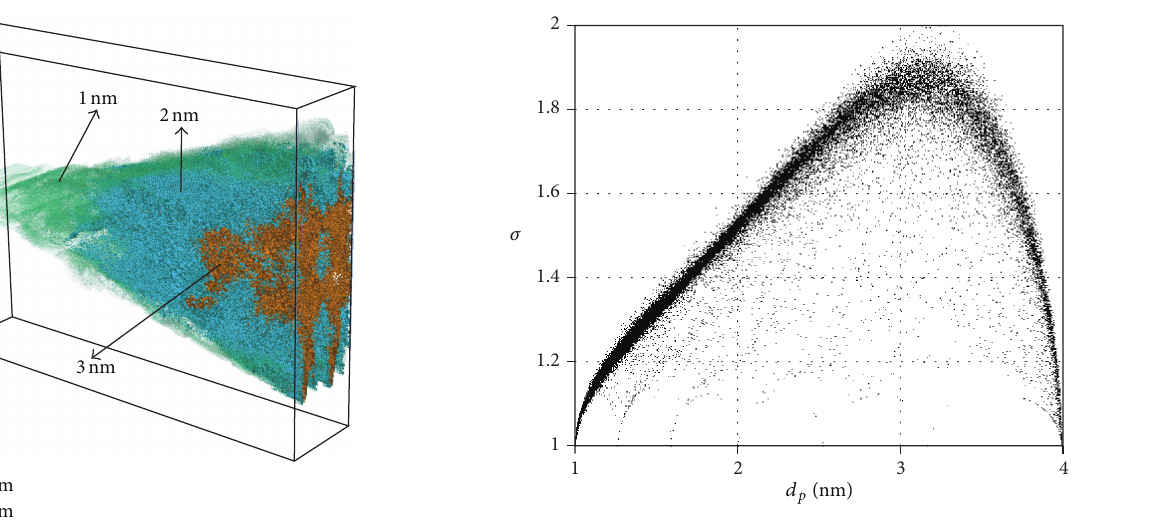
Figure6:Scatterplotofthegeometricstandarddeviation, 𝜎 𝑔 ,versus the mean particle diameter, 𝑑 𝑝